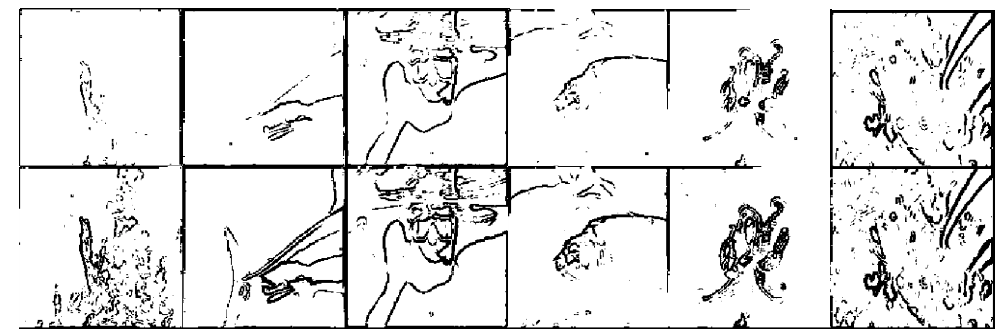
Figure 4. Comparison of experimental results of edge detection.